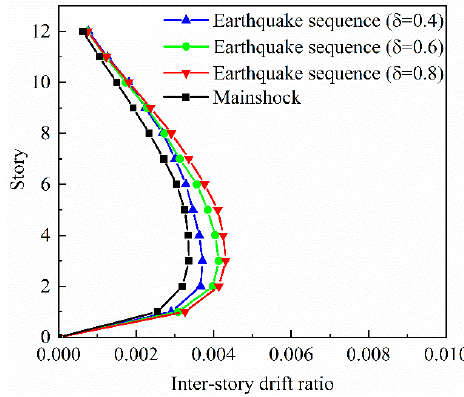
Figure 13. Comparison of the ISDRs of CFST-B under A-CAS input motion. Table 3. Maximum roof displacement under mainshock and earthquake sequence.